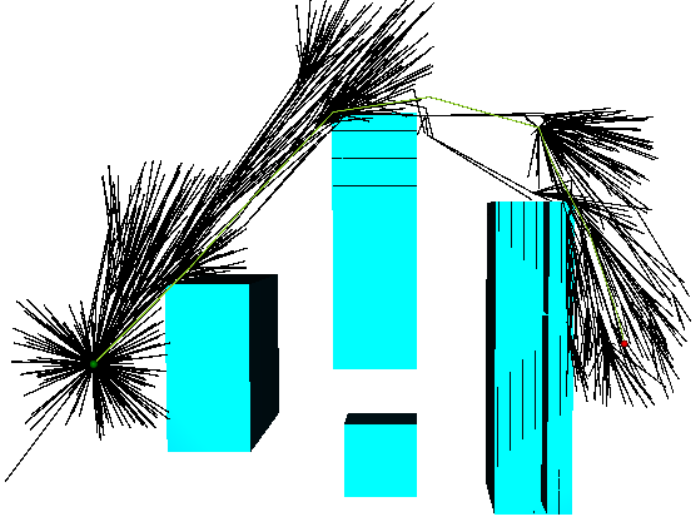
Figure 20. Example result of the improved FMT algorithm with four different obstacles: first step number of samples = 500, second step number of samples = 1500. The generated graph is drawn in black, the obstacle in blue, and the path (start point in green and end point in red) in Table 2. Average Computing Time (ms) for scenraios between two points separated by a distance of 500 cells